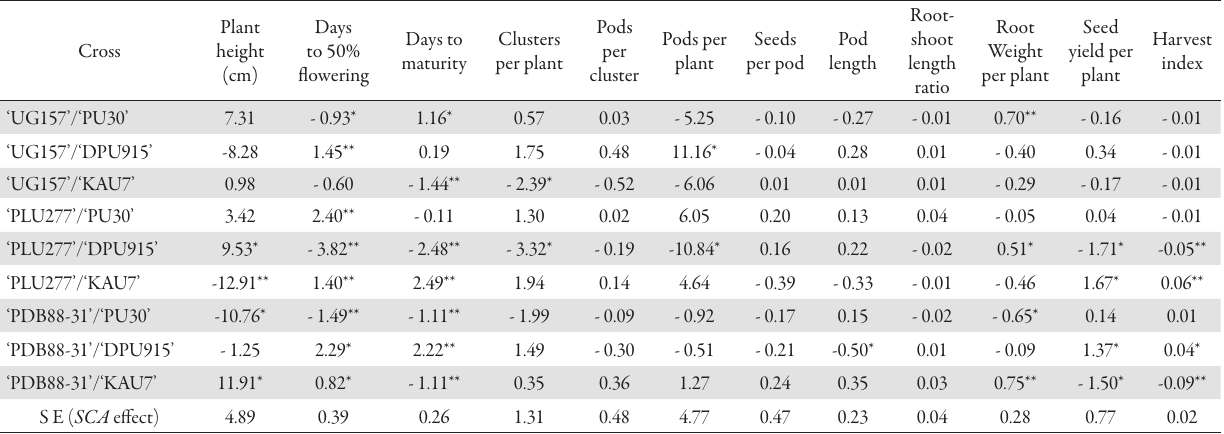
Tab. 5. Estimates of SCA effects of 9 crosses for various quantitative traits in black gram